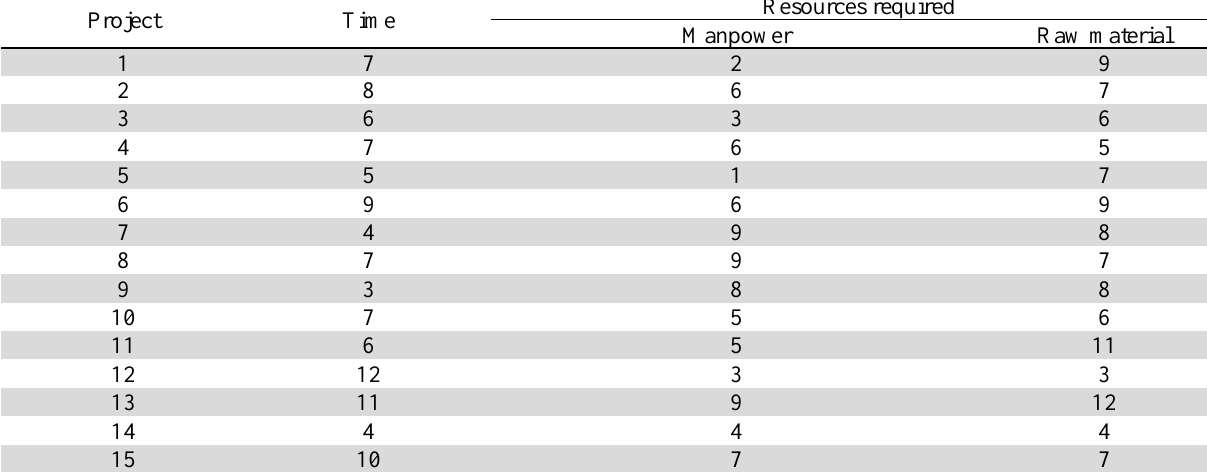
Time and resources needed for execution of each project Project